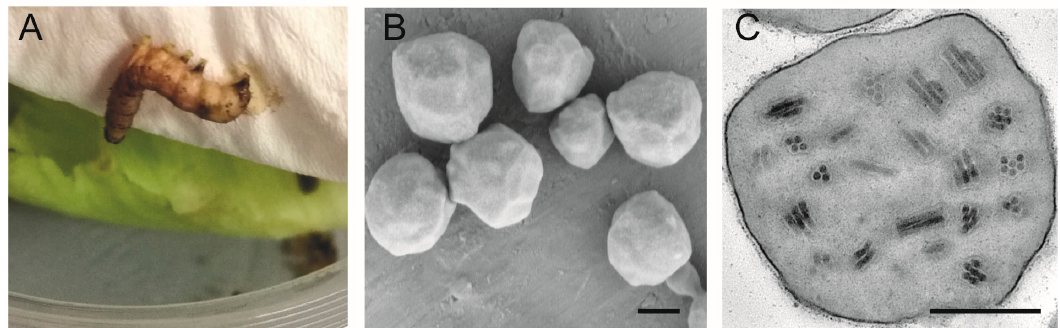
Figure 1. Image of Spodoptera frugiperda larval cadaver showing symptoms of baculovirus infection when reared with the maize crop S. frugiperda larvae in laboratory ( A ), and scanning electron microscopy (SEM) ( B ) and transmission electron microscopy (TEM) ( C ) observation of the isolated Spodoptera frugiperda multiple nucleopolyhedrovirus (SfMNPV) occlusion bodies (OBs). Scale bars = 0.5 μ m.